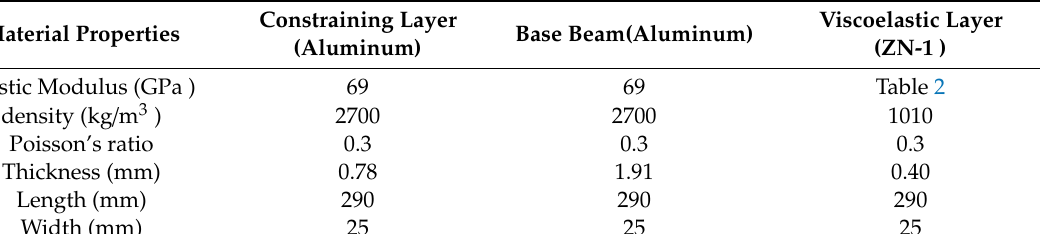
Table 3. Material and mechanical properties of the experimental viscoelastic sandwich beam structure.